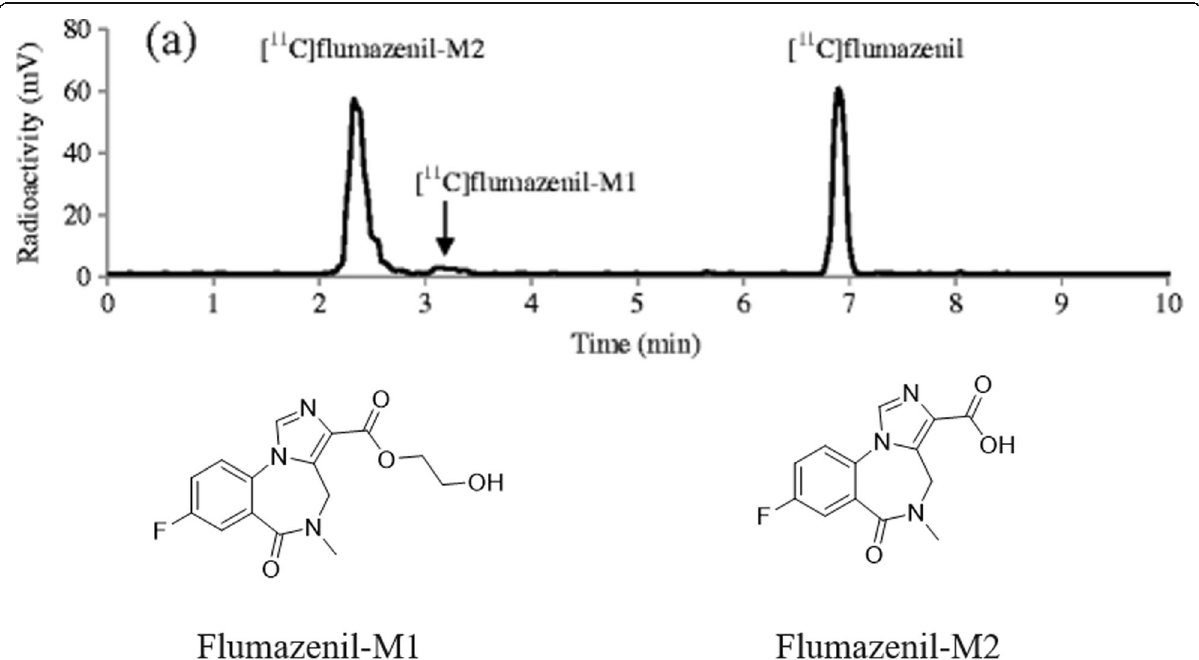
Fig. 4 Fast radio-LC chromatograms of ( a ) rhesus monkey plasma collected 20 min after administration of [ 11 C]flumazenil. Adapted with permission from Ref. [54]